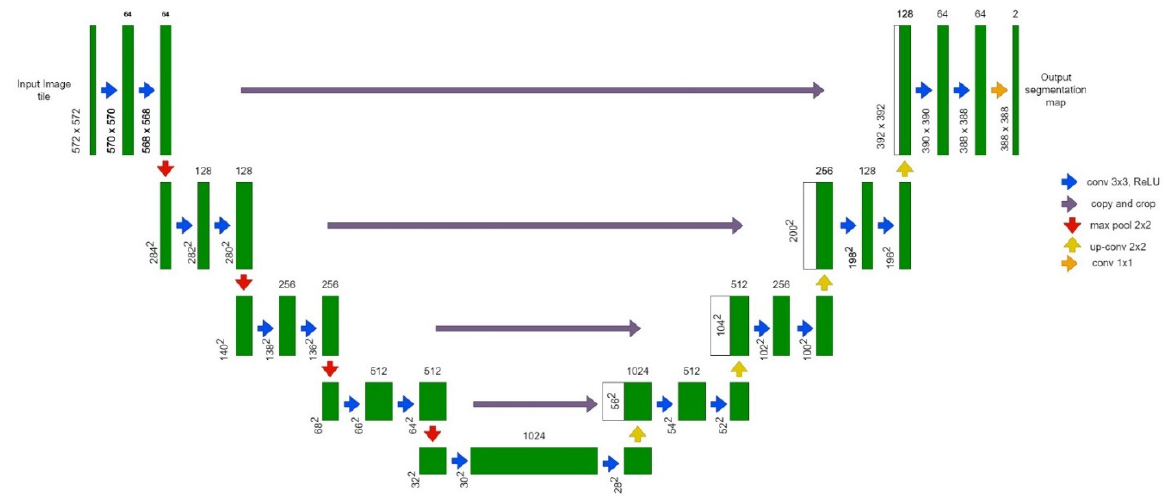
Figure 4. Unet architecture.